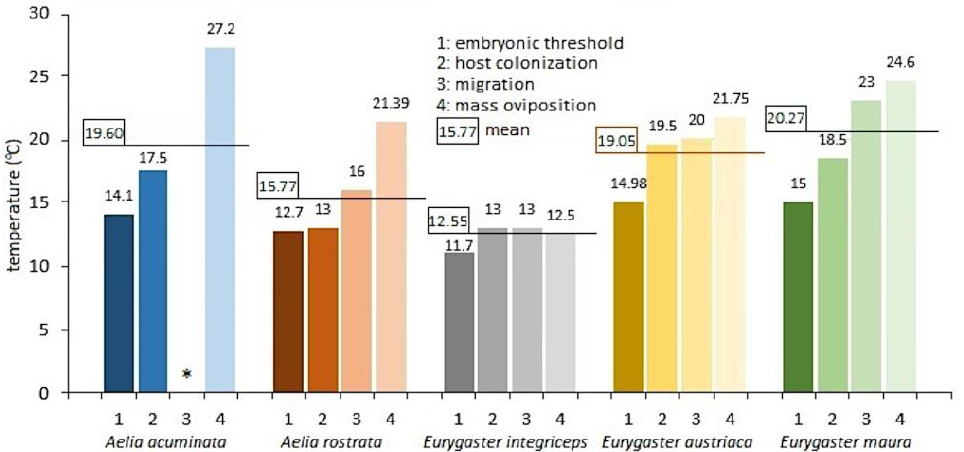
Figure 2. Distinction of sap-sucking heteropterans based on their temperature-depending biological characteristics. *: non-migrating species.